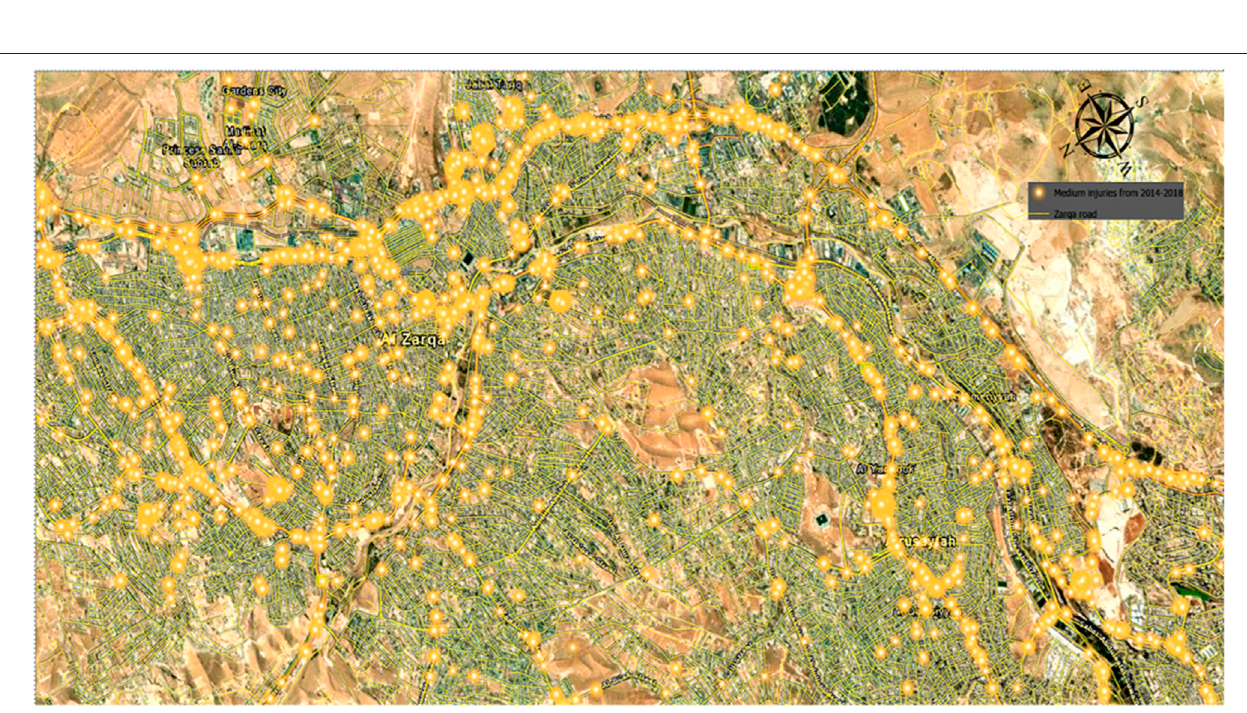
FIGURE 8 | Medium injury crashes for Zarqa City in 2014 –